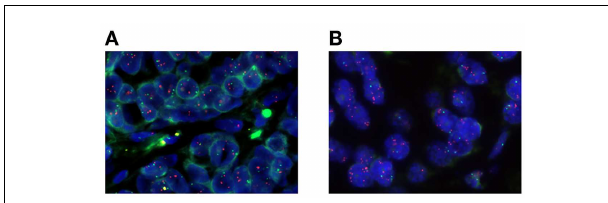
FIGURE 1 | Microscope photographs of two different primary breast cancer specimens stained with a fluorescent TOP1 /CEN-20 fluorescence in situ hybridization (FISH) probe mix . Red spots visualize the TOP1 gene and green spots represent CEN-20. (A) A breast cancer specimen with diploid TOP1 copy number of 2.97, CEN-20 copy number of 1.90, and a ratio of 1.56. (B) A breast cancer specimen with amplified TOP1 copy number of 6.35, CEN-20 copy number of 1.90, and a ratio of